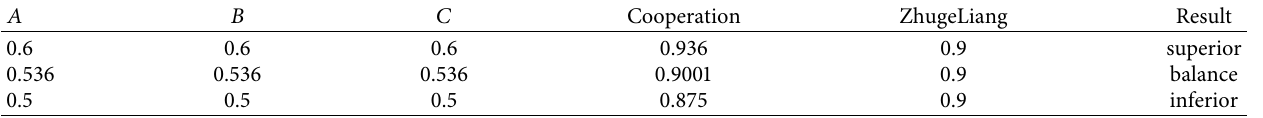
Table 1: The probability test of balancing point of the three cobblers working together and Zhuge Liang working alone. A B C